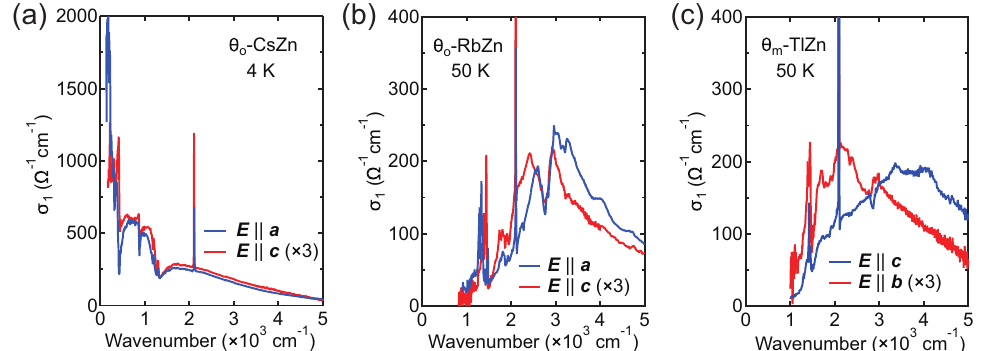
Figure 5. Polarization dependence of optical conductivity spectra in the charge–glass/crystal states of the θ –type salts. ( a – c ) Optical conductivity spectra of ( a ) the charge-glass state in θ o -CsZn for E (cid:107) a (blue) and E (cid:107) c (red) measured at 4K, ( b ) the charge-crystal state in θ o -RbZn for E (cid:107) a (blue) and E (cid:107) c (red) measured at 50K, and ( c ) the charge-crystal state in θ m -TlZn for E (cid:107) c (blue) and E (cid:107) b (red) measured at